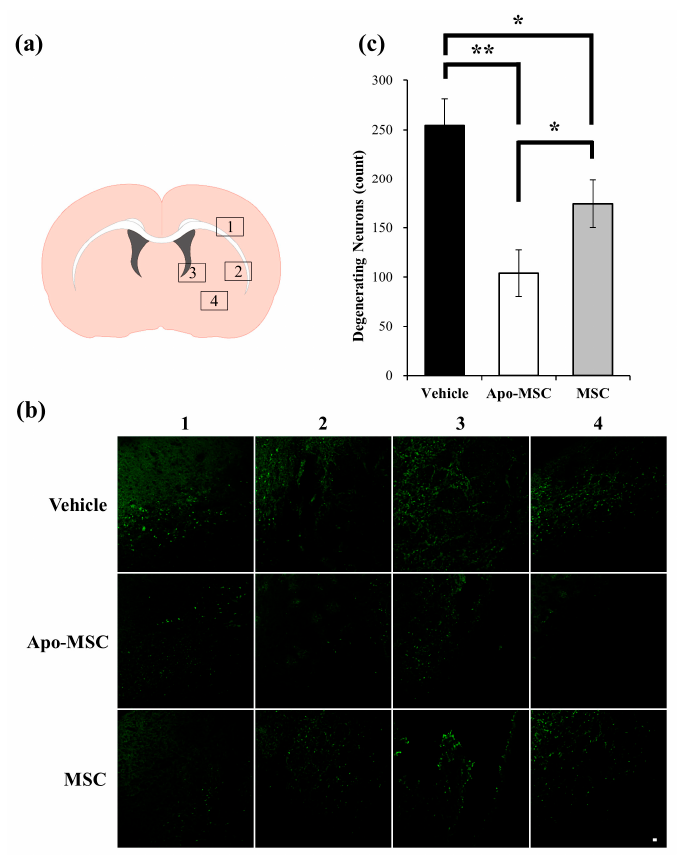
Figure 2. Effect of apocynin-preconditioned human placenta-derived mesenchymal stem cells (Apo-MSCs) and naïve MSCs on the peri-hematoma neuronal death in the rats at 48 h after the induction of an intracranial hemorrhage (ICH). ( a ) The location of core hemorrhagic regions at 0.2 mm from the bregma. Each number represents a region of interest to be analyzed. ( b ) Fluorescence images reveal the degenerating neurons in the peri-hematoma region at 24 h after the induction of an ICH. Degenerating neurons are detected by Fluoro-Jade C (FJC) staining (green). Each number represents a region of interest defined at Figure 2a. Scale bar = 20 µ m. ( c ) The bar graphs represent the count of FJC-positive neurons in the peri-hematoma region from the Apo-MSCs, naïve MSCs and vehicle treated groups at 48 h after ICH induction. Data are mean +SD. * p < 0.05, ** p < 0.01.